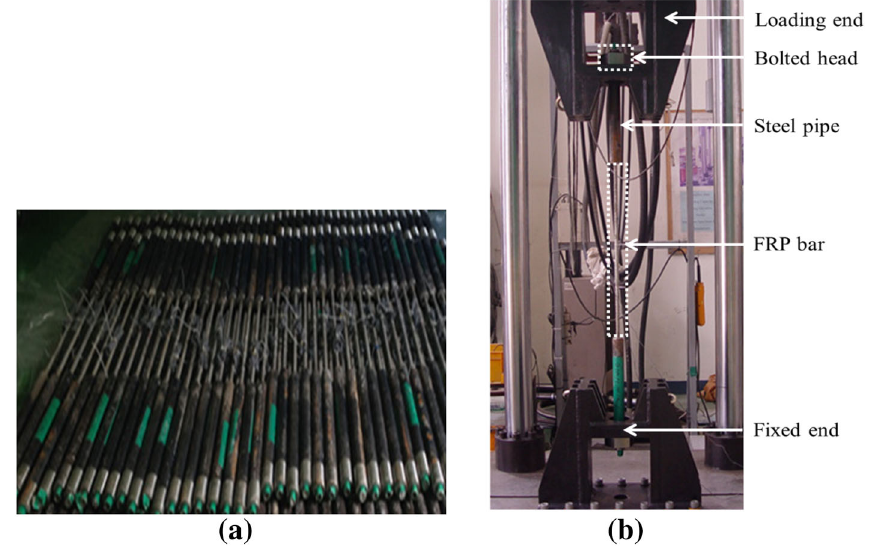
Fig. 4 Test specimens and set up. a Fabricated test specimens, b Test set